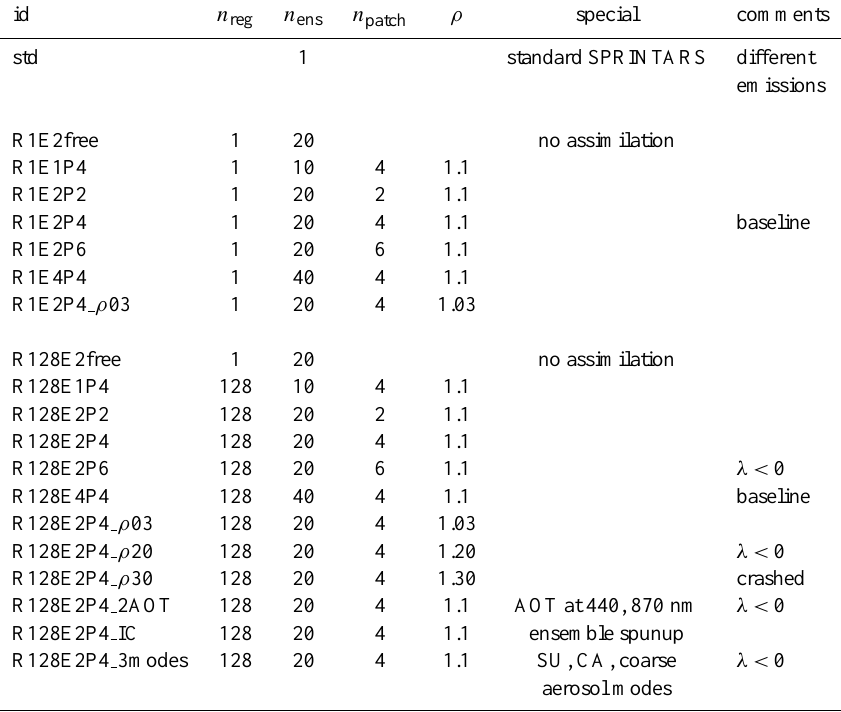
Table 1. Assimilation experiments used in this